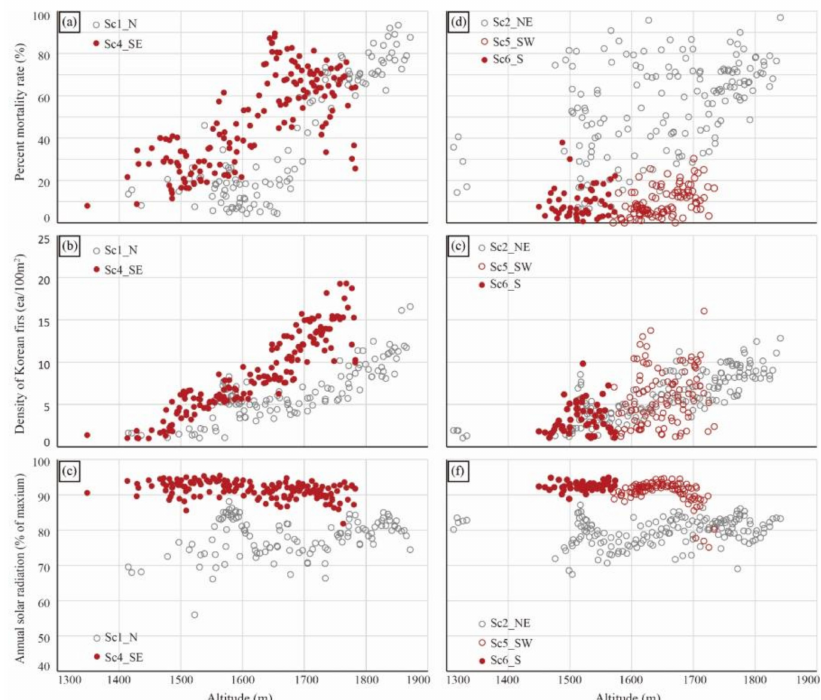
Figure 4. Altitudinal variation of the APMR, density of the Korean fir, and annual solar radiation on di ff erent aspects of Mt. Halla. ( a – c ) show the data for the northern and southeastern sections of Mt. Halla and ( d – f ) show the data for the northeastern and southwestern sections of Mt. Halla. Locations of each section are shown in Figure